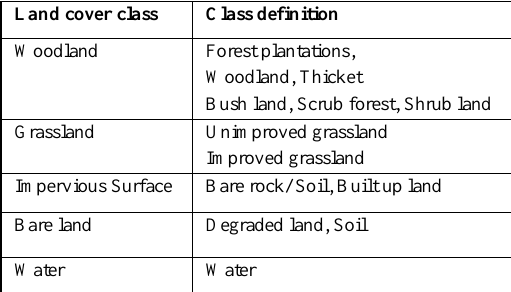
Table 2: Land cover classes defined for the study